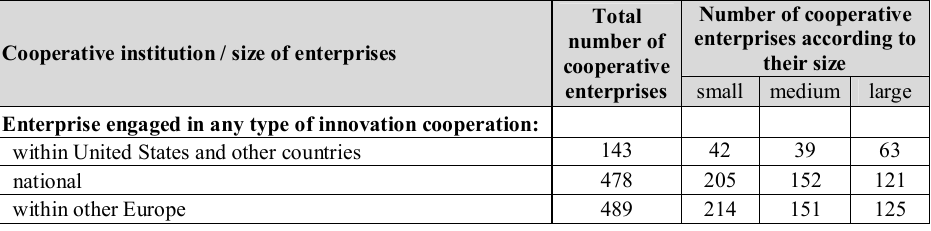
Number of cooperative Total enterprises according to number of their size cooperative enterprises small medium large